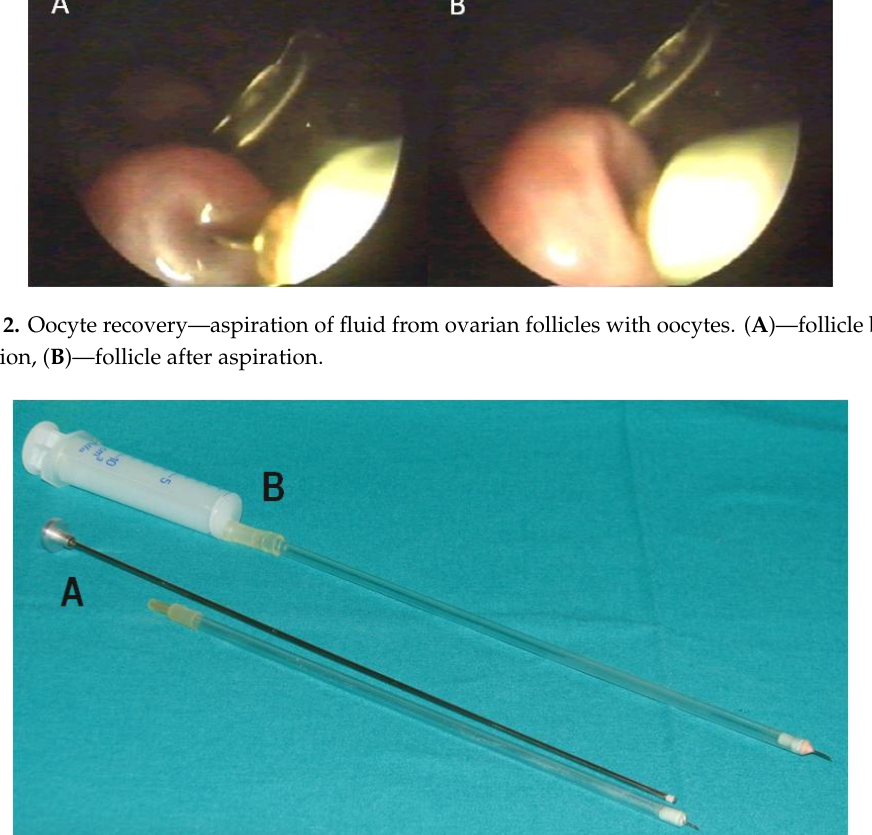
Figure 2. Oocyte recovery—aspiration of fluid from ovarian follicles with oocytes. ( A )—follicle before aspiration, ( B )—follicle after aspiration.